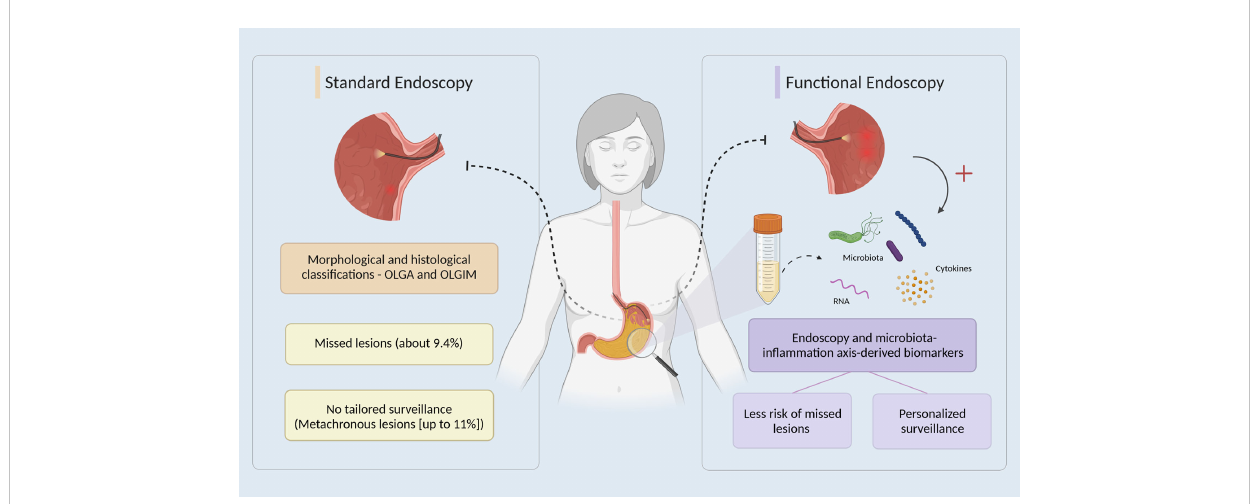
FIGURE 1 The potential of functional endoscopy in gastric cancer early detection and management. In standard endoscopy (left side), after an upper gastrointestinal endoscopy, patients are strati fi ed using OLGA and OLGIM classi fi cations, which rank the severity and topography of atrophic and IM alterations in gastritis (13). However, endoscopy alone is associated with a non-negligible rate of missed conditions and a signi fi cant risk of metachronous lesions development (15, 16). On the right side, the promise of functional endoscopy by also integrating, for example, dysbiosis-driven in fl ammatory biomarkers derived from liquid biopsies, namely gastric juice, towards the individualization of care by targeting a reduction of missed lesions and personalization of patients ’ management in gastric cancer early